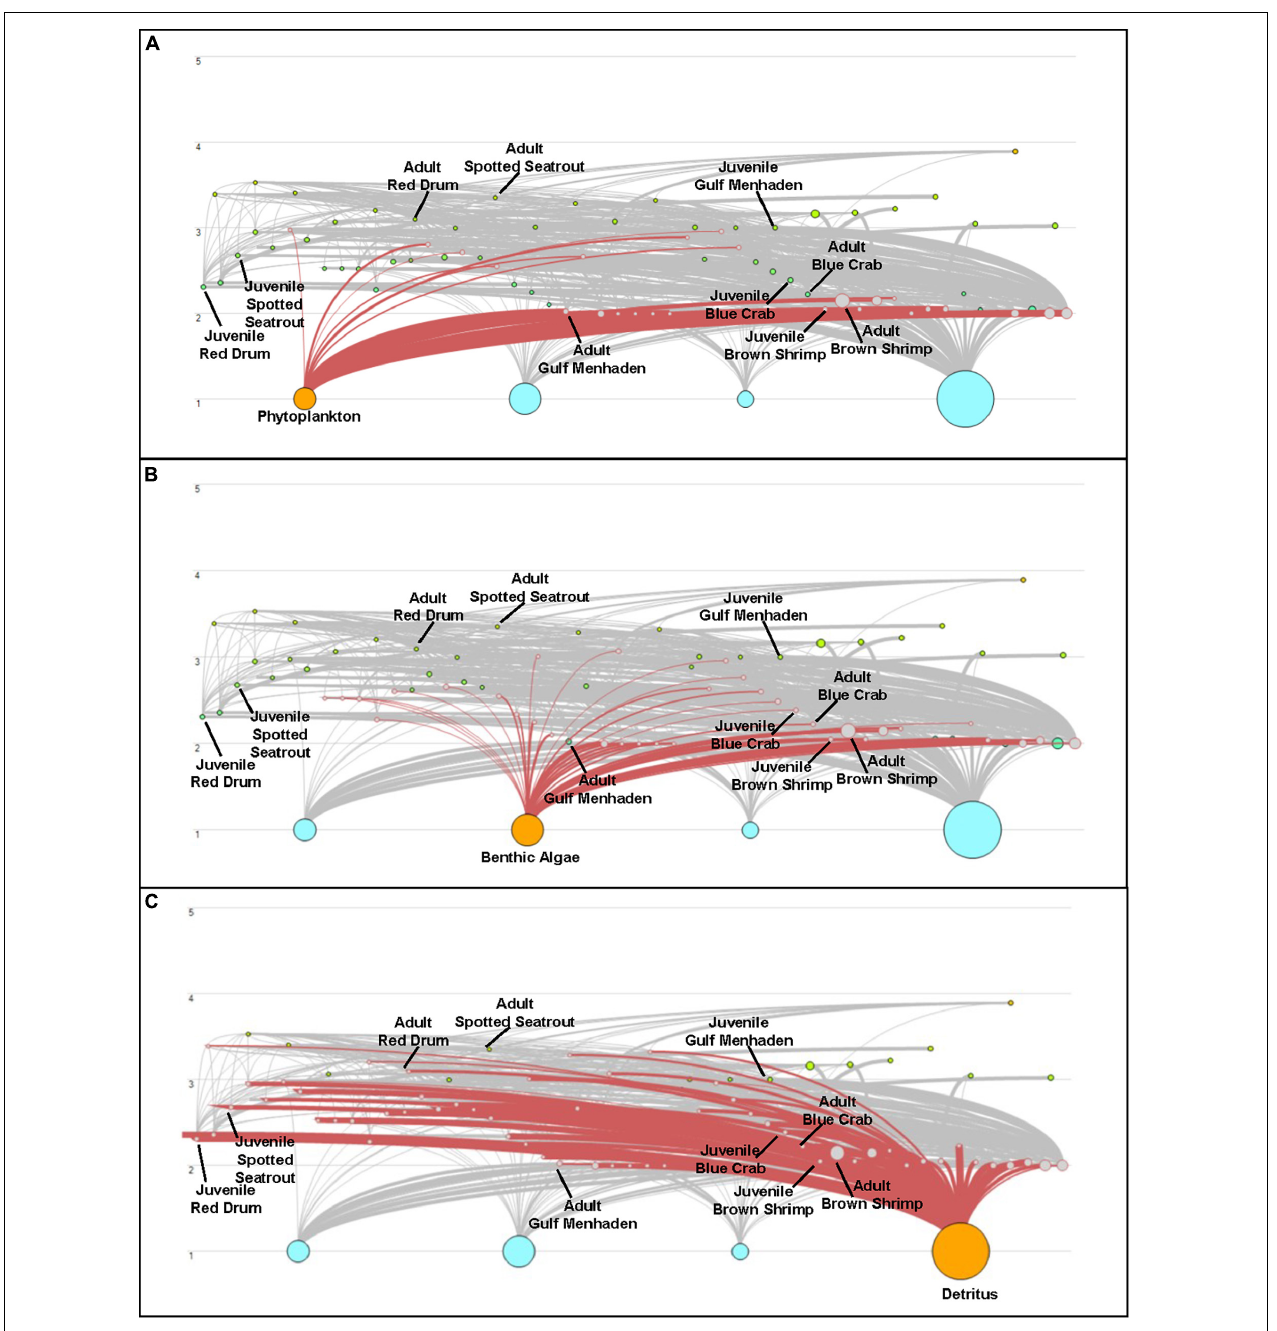
FIGURE 9 | Energy Flow diagrams from the Ecopath base model used in the Ecosim calibration simulation to highlight net production of detritus in the model compared to other producer compartments. Trophic level is indicated on the y-axis; the size of the dots indicates the size of the biomass pools. Energy flow (t km − 2 yr − 1 ) from phytoplankton (A) , Benthic Algae (B) , and Detritus (C) is highlighted. This figure represents the key species found in both the CASM and EwE